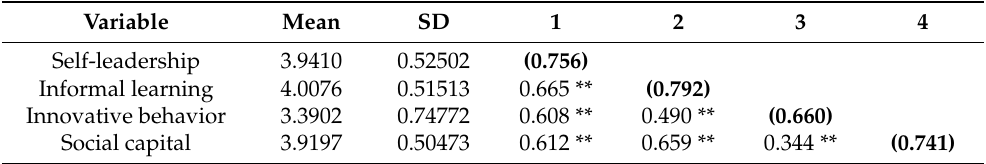
Table 3. Correlation and discriminant